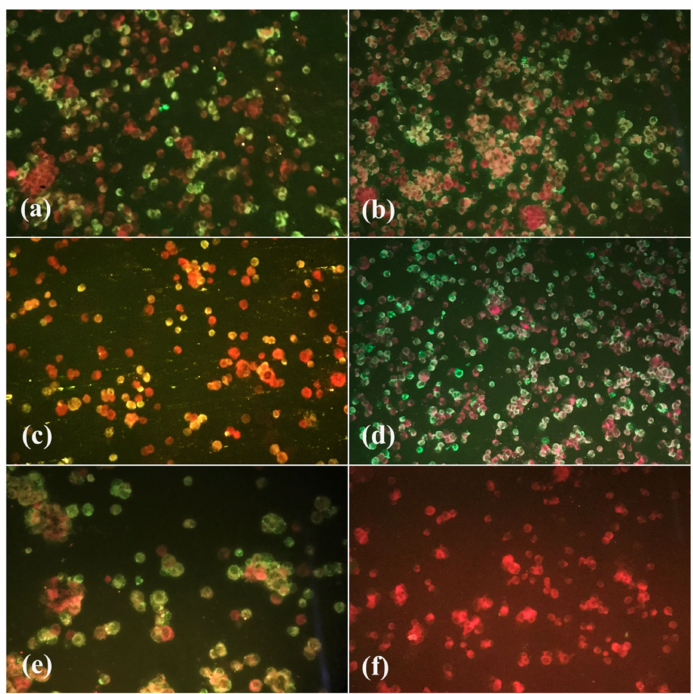
Figure 3. Indirect immunofluorescence of Culex quinquefasciatus body, head, and saliva samples from Cidade Nova neighborhood (group 2). ( a ) Positive 7th dpi body sample; ( b ) positive 21st dpi body sample; ( c ) positive 21st dpi head sample; ( d ) positive 21st dpi saliva sample; ( e ) positive control; ( f ) negative control. Images were taken at 100 ×